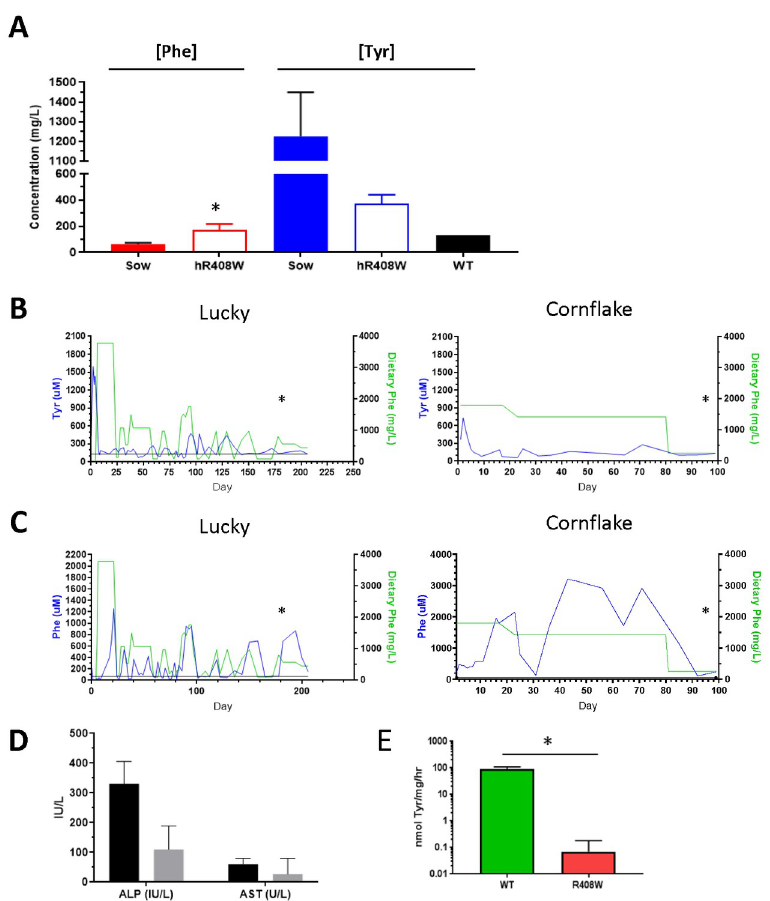
Fig 3. PAH -targeted phenotype characterization. A) Yorkshire founder PKU piglets maintained on NTBC were analyzed at birth for circulating phenylalanine and tyrosine levels, compared to the sow (assayed a C-section). Wild type tyrosine level is represented for comparison due to the elevated levels present in the sow, as maintained on NTBC. B) Two piglets (Lucky and Cornflake) were maintained continuously to characterize the R408W/x metabolic phenotype. Tyrosine levels (blue) were elevated at birth due to NTBC administration during gestation, and showed muted responsiveness dietary phenylalanine available during development (green). C) Serum phenylalanine levels (blue) were well correlated with dietary phenylalanine (green), indicative of disrupted phenylalanine metabolism, modeling human disease. Asterisk represents timing of clinical chemistry analysis in the next panel. D) Liver enzyme analysis of the long term piglet (Lucky) showed healthy ALP and AST levels while maintained on phenylalanine- restricted diet. E) PAH activity was assayed from liver homogenates of animals harvested within 1 week of birth demonstrating nearly complete ablation of activity despite expression, indicating loss of function from the hR408W mutation. � p < 0.05 compared to WT sow (A) or age matched control (E).